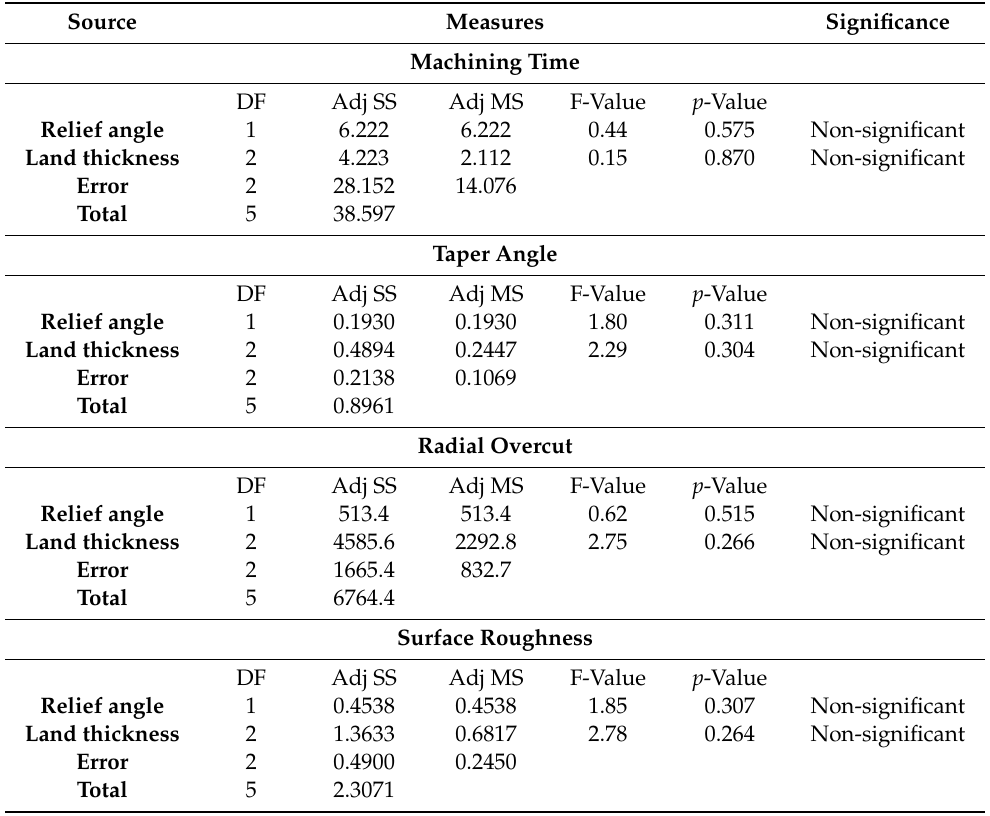
Table 8. Analysis of variance for machining